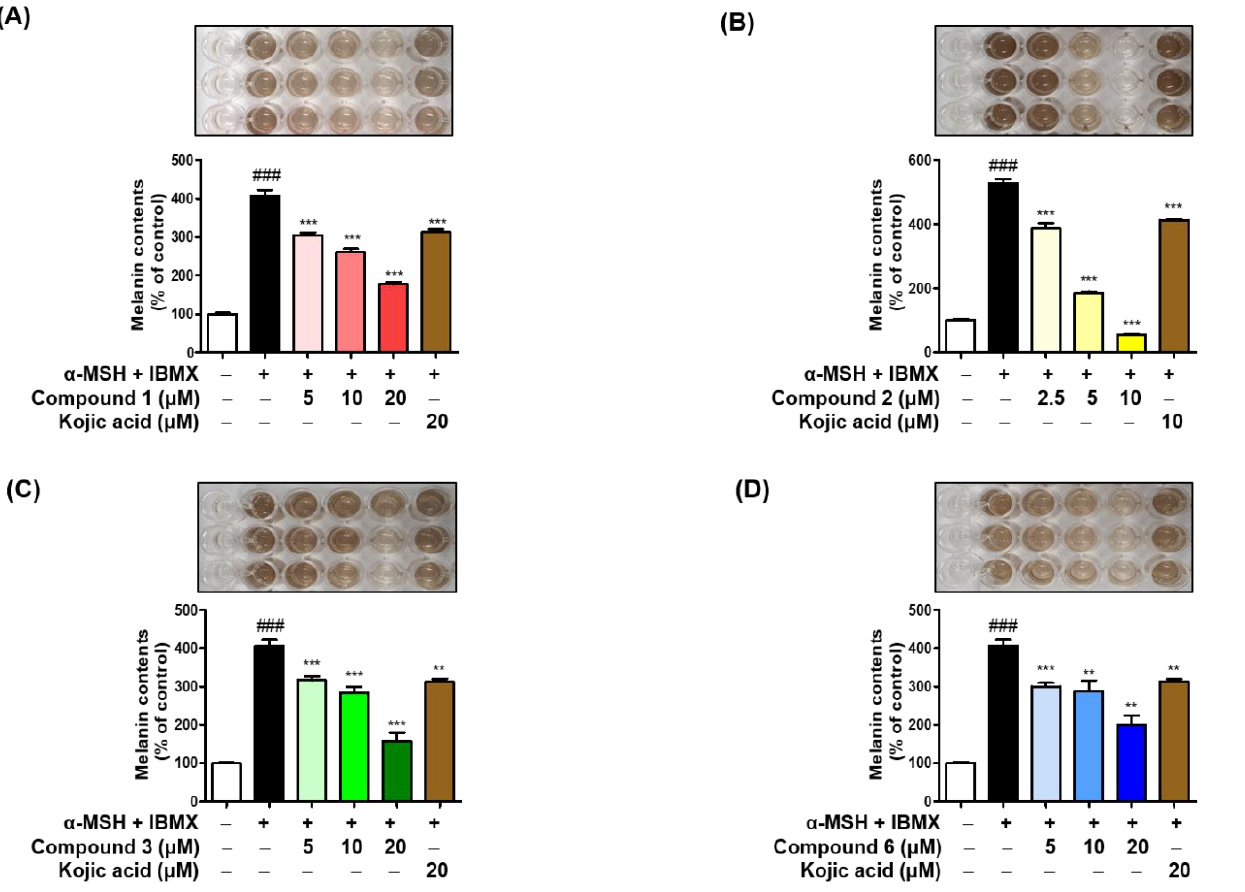
Figure 9. Effects of analogs 1 ( A ), 2 ( B ), 3 ( C ), and 6 ( D ) on cellular melanin production in B16F10 cells co-stimulated with α -MSH (1 µ M) and IBMX (200 µ M). B16F10 cells were treated with analogs 1 , 2 , 3 , or 6 (at 0, 5, 10, or 20 µ M for analogs 1 , 3 , and 6 , or 0, 2.5, 5, or 10 µ M for analog 2 ). Kojic acid at 10 or 20 µ M was used as a positive control. Melanin contents are expressed as percentages of non-treated controls and bars represent standard errors. Symbols # and * indicate significant differences between columns: ### p < 0.001 for non-treated controls versus cells co-treated with α -MSH and IBMX; ** p < 0.01, and *** p < 0.001 for cells co-stimulated with α -MSH and IBMX versus α -MSH plus IBMX plus analog 1 , 2 , 3 , or 6 or kojic acid-treated cells. All experiments were repeated independently in